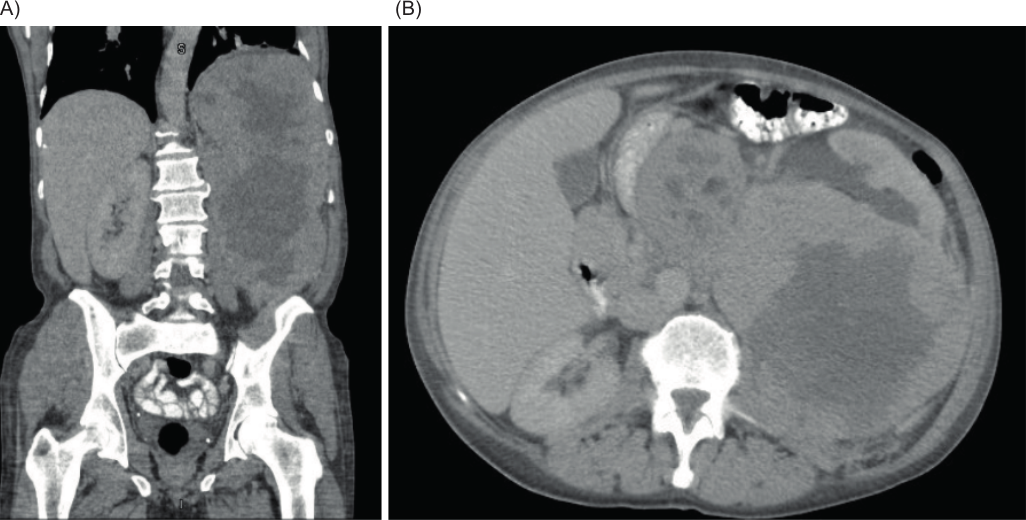
Figure 1: Abdominal CT images with contrast. CT images of the abdomen in coronal (A) and axial (B) planes with contrast enhancement demonstrating a large left retroperitoneal